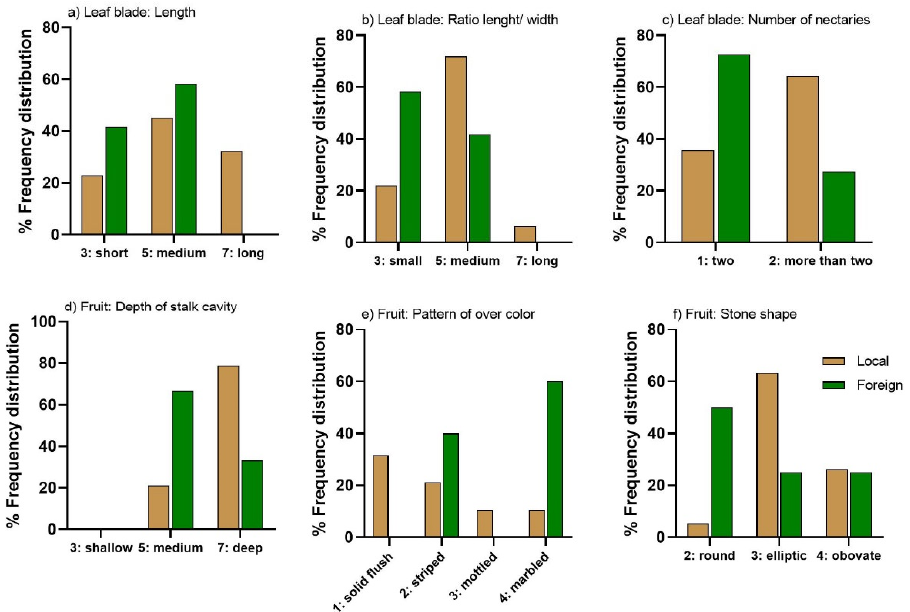
Figure 2. Frequency distribution of leaf: ( a ) length, ( b ) ratio length/width, and ( c ) number of nectaries, and fruit: ( d ) depth of stalk cavity, ( e ) pattern of over color, and ( f ) stone shape, traits in the local and foreign peach cultivars studied.